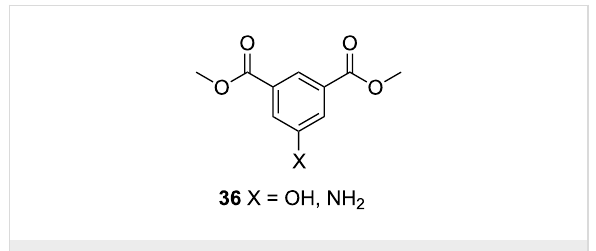
Figure 13: C-5-substituted isophthalates.